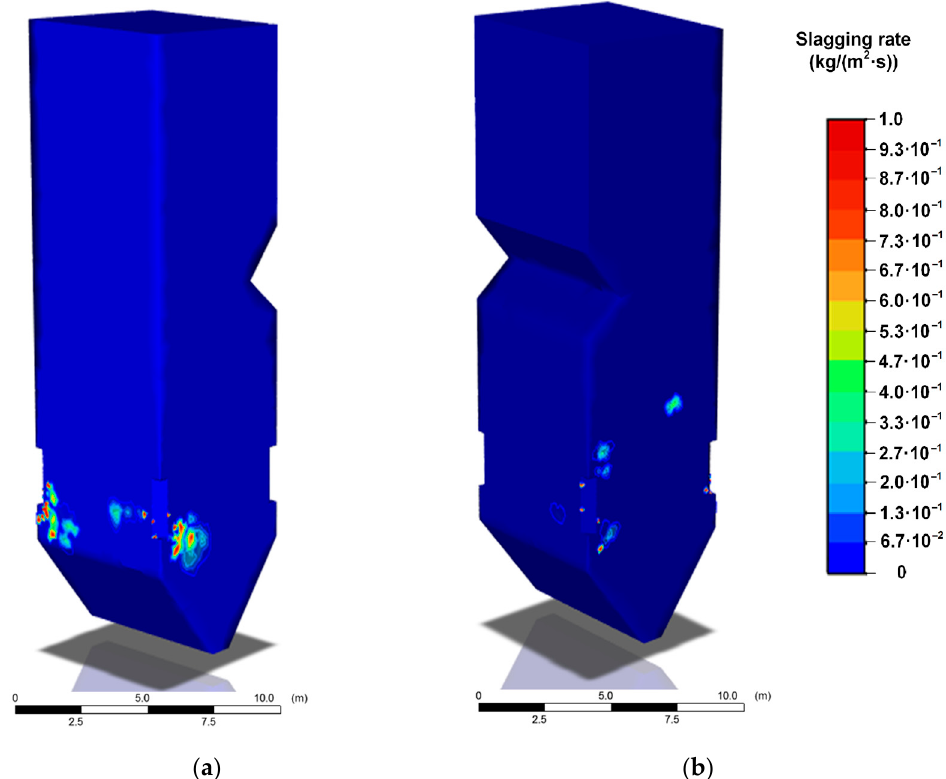
Figure 8. Typical fields of slagging rates of furnace walls when burning CWSP: from the front side of the furnace ( a ); from the back side of the furnace ( b ).